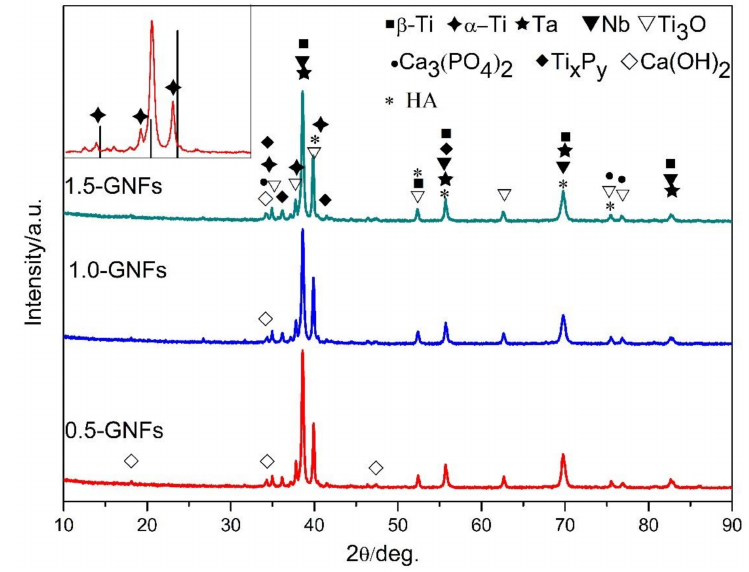
Figure 4. X-ray diffraction patterns of nanocomposites sintered at 1000 ◦ C. A comparison with α -Ti standard card (44-1294) is shown in the upper left